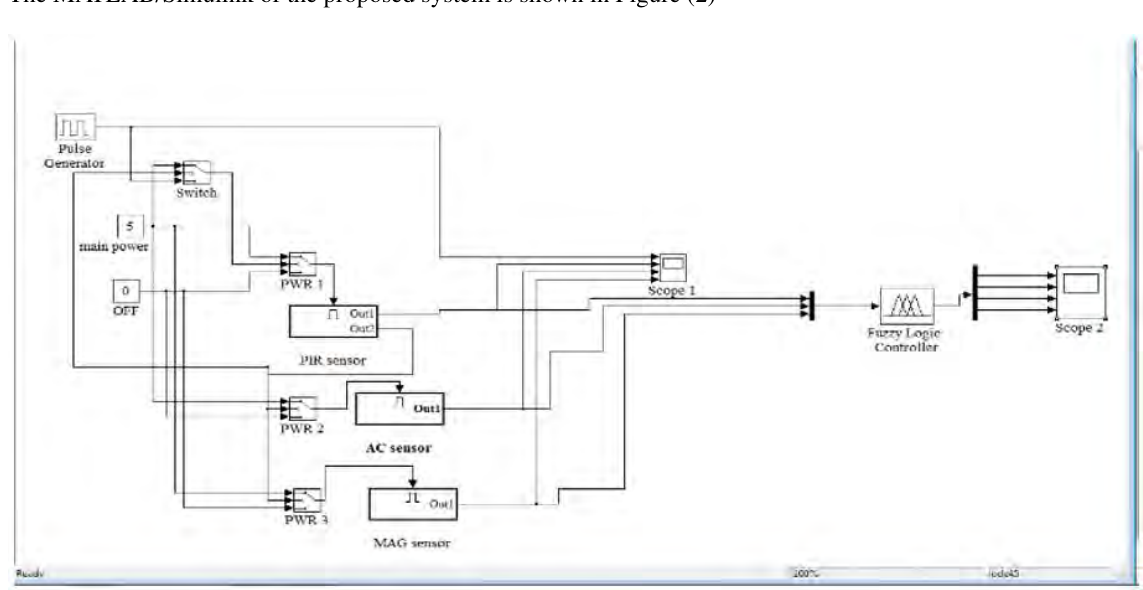
Figure 2. The proposed system simulation in MATLAB Simulink.